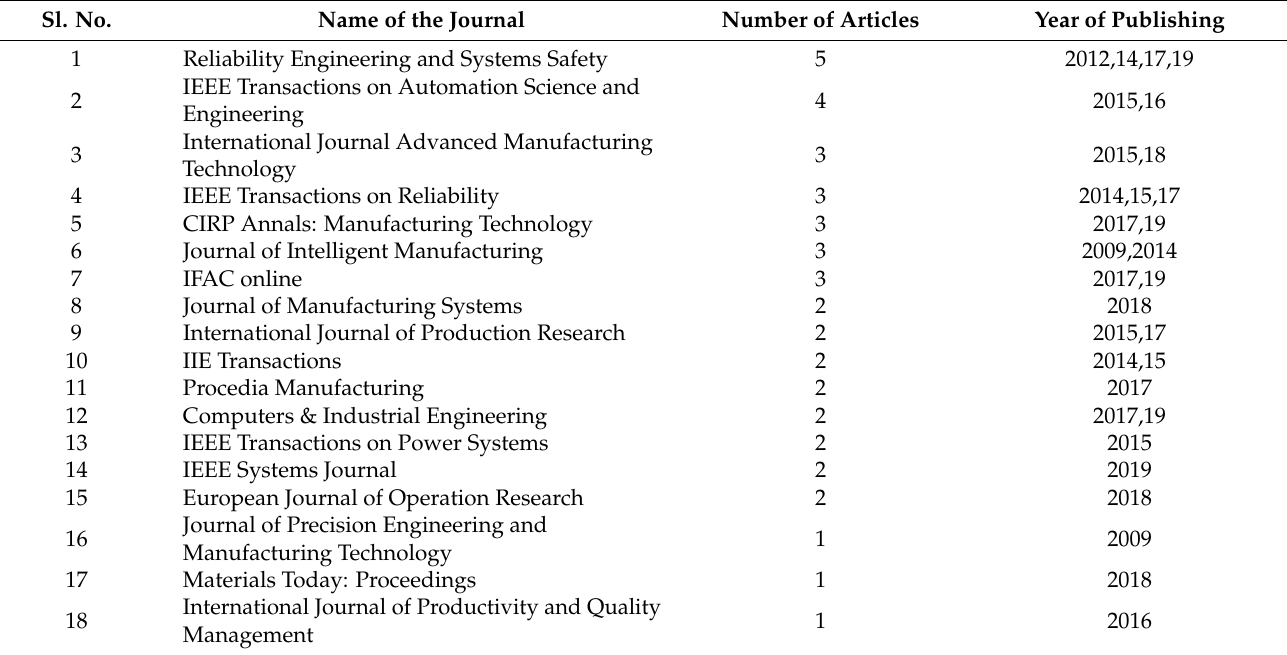
Table 5. List of journals related to the parameters related to the flexible unit systems. Sl.